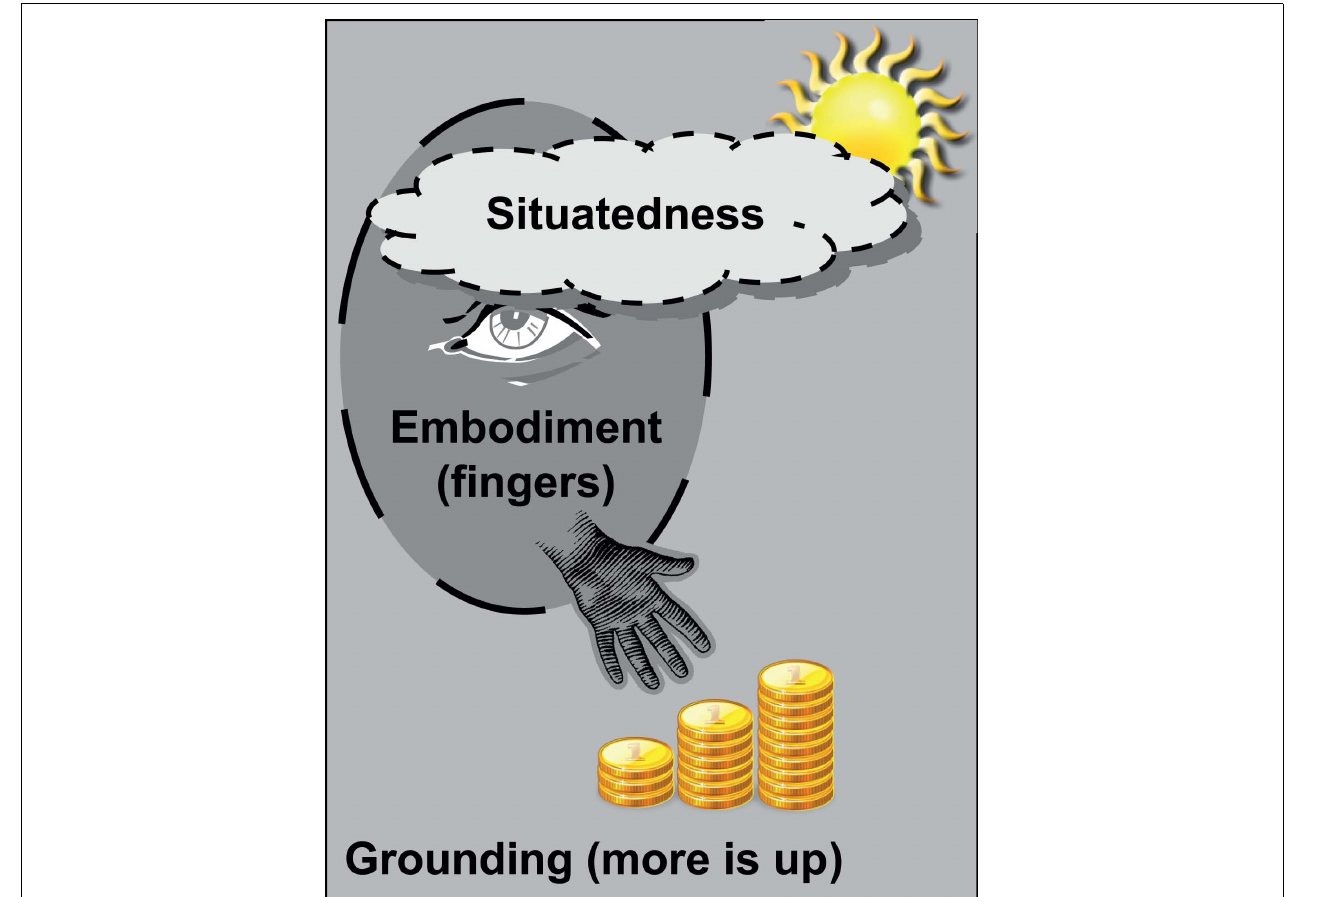
FIGURE 3 | Illustration of the hierarchical relationship of grounded, embodied, and situated cognition in the numerical domain.